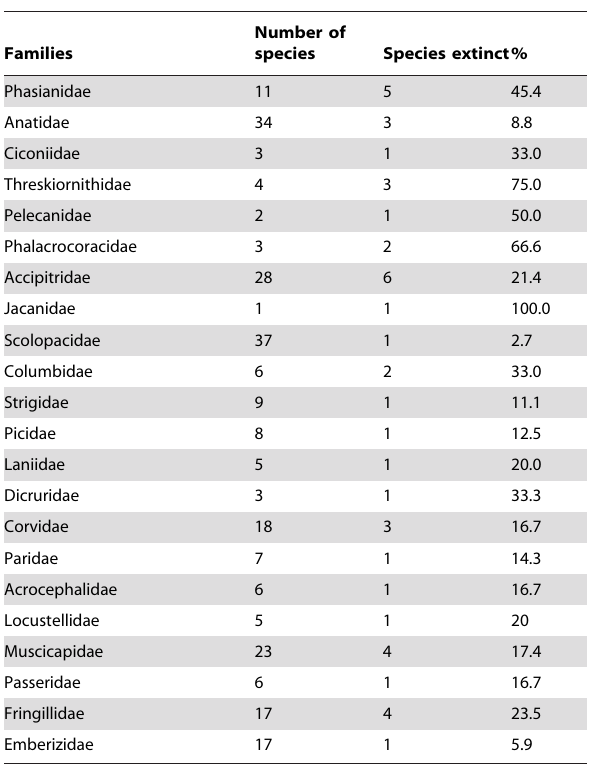
Table 4. Percentage of local extinctions in some bird families in the Greater Beijing Area during the period 1938 2 2007 (only families in which extinctions were recorded are